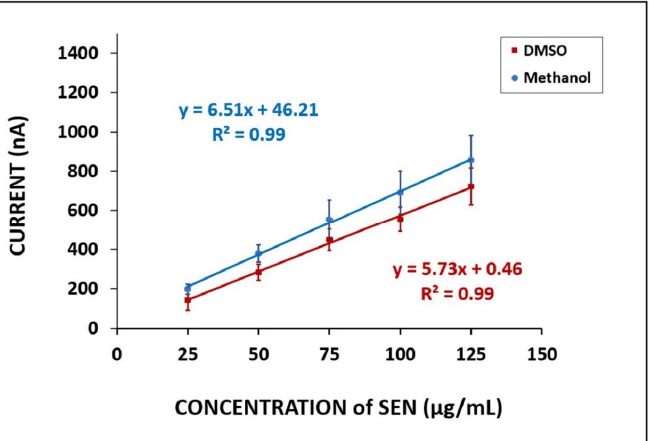
Figure 4. The calibration plots representing the average oxidation signal of SEN dissolved in different media: DMSO and methanol. SEN concentrations varied from 25 to 125 µg/mL. The selectivity of our electrochemical assay to SEN over to other pyrrolizidine alka- loids, such as intermedine, lycopsamine, and heliotrine, was studied individually as well as in mixture samples containing 25 µg/mL of SEN and 25 µg/mL of intermedine, ly- copsamine, or heliotrine. The resulting voltammograms are shown in Figure 5. The oxi- dation signals of 25 µg/mL and 100 µg/mL SEN were measured as 209.67 ± 15.76 nA (RSD%, 7.52%, n = 6) and 718.75 ± 48.30 nA (RSD%, 6.72%, n = 6), respectively. In addition, the oxidation signals of 25 and 100 µg/mL intermedine (Figure 5A (c,d)), lycopsamine (Figure 5C (c,d)), and heliotrine (Figure 5E (c,d)) were also measured individually in buffer medium. No oxidation signal of intermedine (Figure 5A (c,d)) and lycopsamine (Figure 5C (c,d)) was measured in the same voltammetric scale from +0.85 to 1.0 V at both a concentration value of 25 µg/mL and 100 µg/mL. However, there were very negligibly low signals measured (i.e., 7.33 ± 17 nA and 61.50 ± 76.53 nA) in the presence of 25 and 100 µg/mL heliotrine alone (Figure 5E (c,d)); these signals were not found to be significant enough to be evaluated. The lack of interferents signal in this potential range has been a substantial datum in terms of the selectivity of our electrochemical assay. Moreover, the selectivity was tested in the mixture of SEN/intermedine (1:1), SEN/lycopsamine (1:1), and SEN/heliotrine (1:1) under the same conditions, and the oxidation signals were examined. The oxidation signal of SEN in the absence/presence of these pyrrolizidine alkaloids are listed in Table 1.